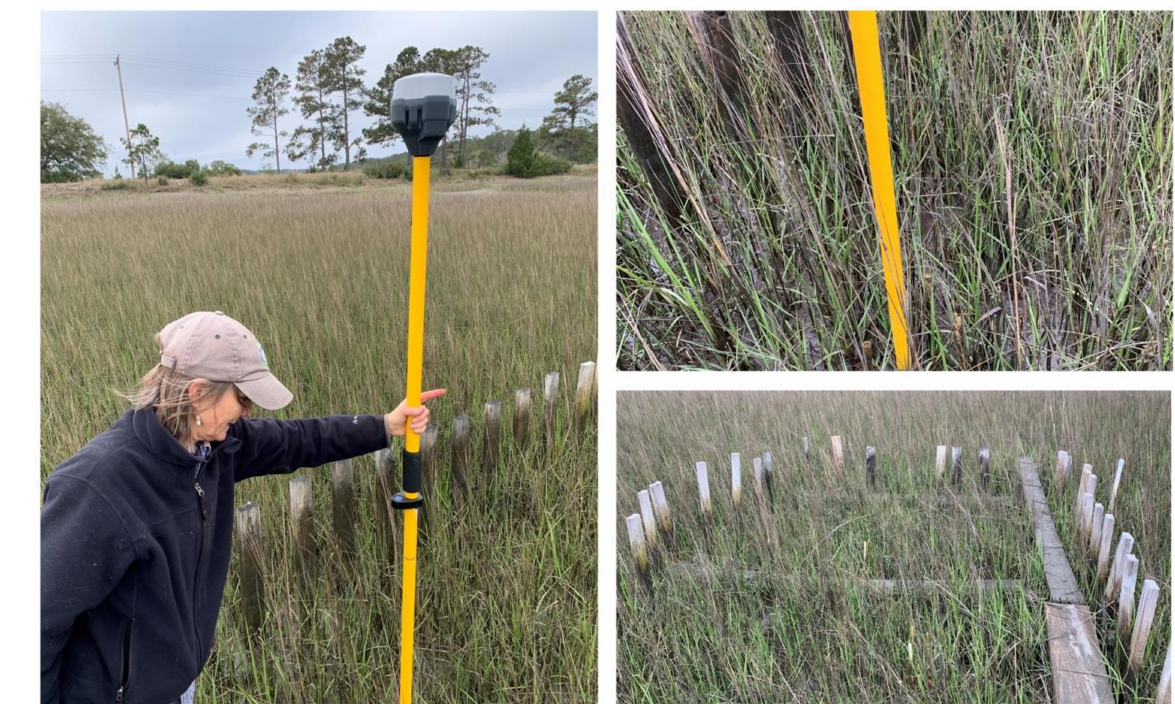
Figure 4. Example plot (bottom right) for ground biomass collection. The Emlid Reach RS2 base (not pictured) and rover were used to collect subplot centroid locations in March 2021. Centroid locations have not changed since